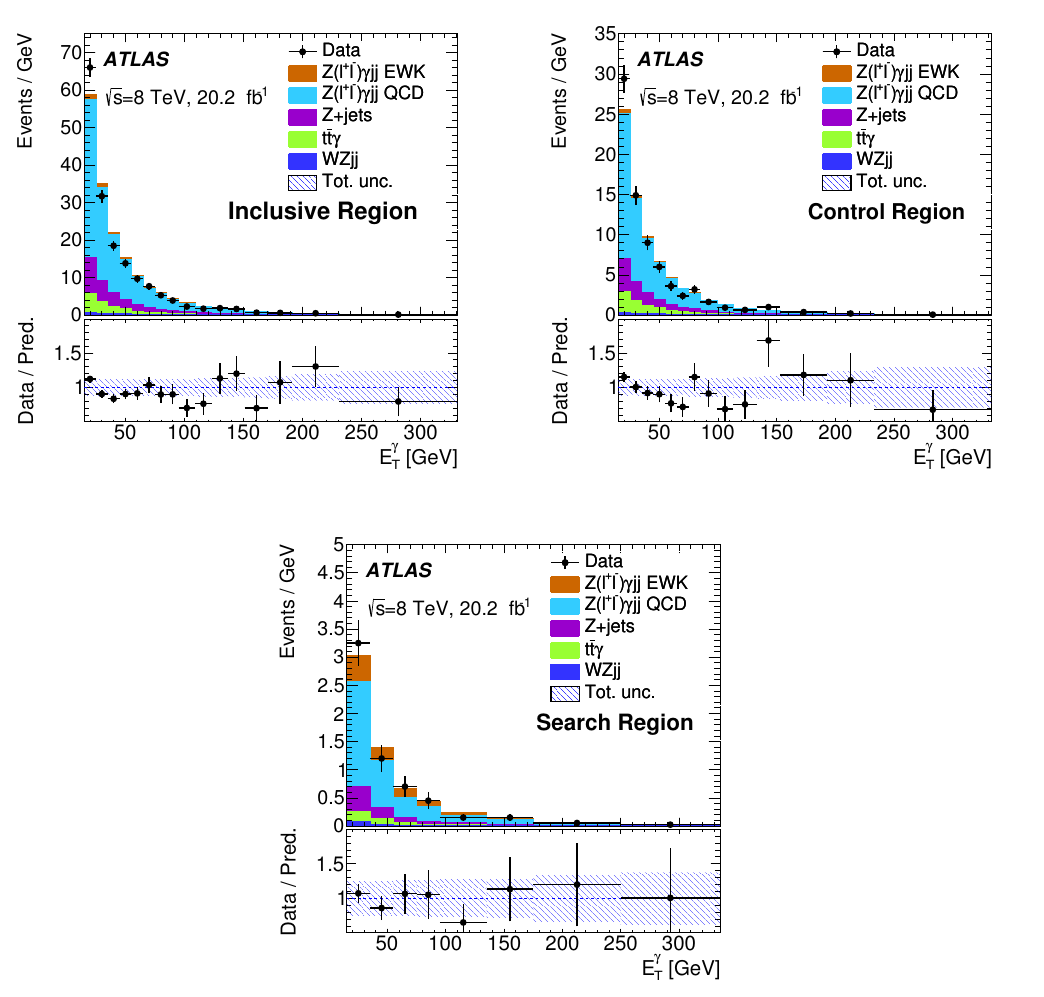
Figure 2 . Distributions of the photon transverse energy for the electron and muon channels added together in the inclusive region (top left), in the control region (top right) and in the search region (bottom), for the data (black points), and for the signal process and various background components (coloured templates) before any (cid:12)t is done. The ratio of the data to the sum of all pre- (cid:12)t expected contributions (\Pred.") is shown below each histogram. The hatched blue band shows the systematic and statistical uncertainty added in quadrature (\Tot. unc.") in the signal and background prediction, while the error bars on the data points represent the statistical uncertainty of the data set. The number of events in each bin is divided by the bin width. The last bin also includes events beyond the range